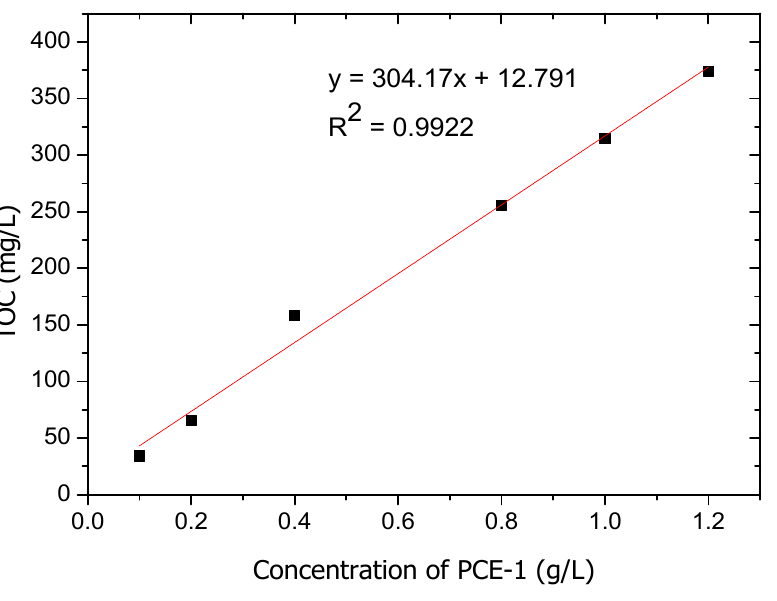
Figure 4. The adsorption standard curve of PCE-1 .